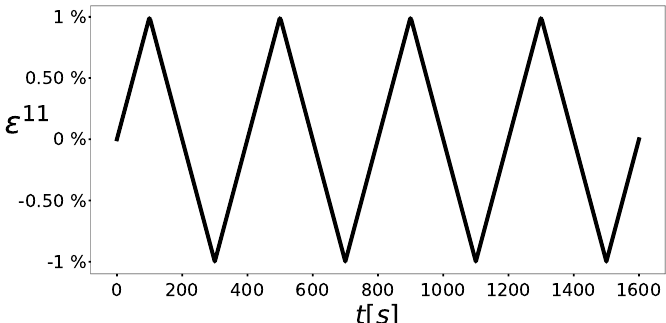
Figure A1. The applied strain component ε 11 ( t ) consists of a triangular pattern of period 400 s with a peak-to-peak amplitude of 2% centered at